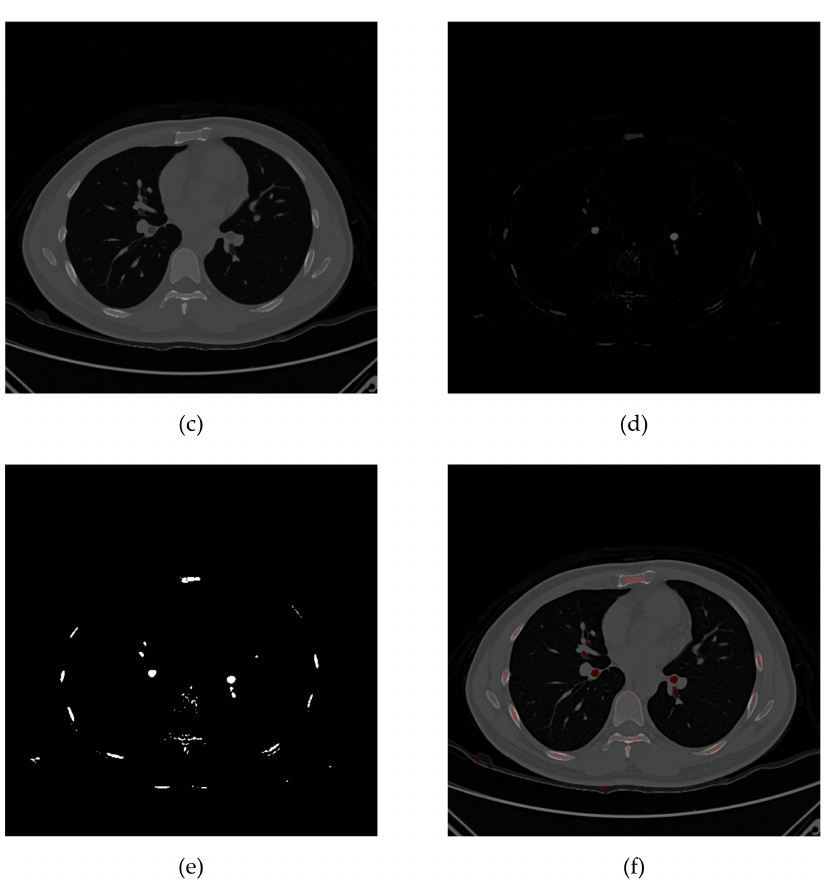
Figure 6. Grayscale reconstruction flow chart. ( a ) Original image; ( b ) labeled image; ( c ) grayscale reconstruction image; ( d ) local difference image; ( e ) local valley target; ( f ) original image marked with local valley target.